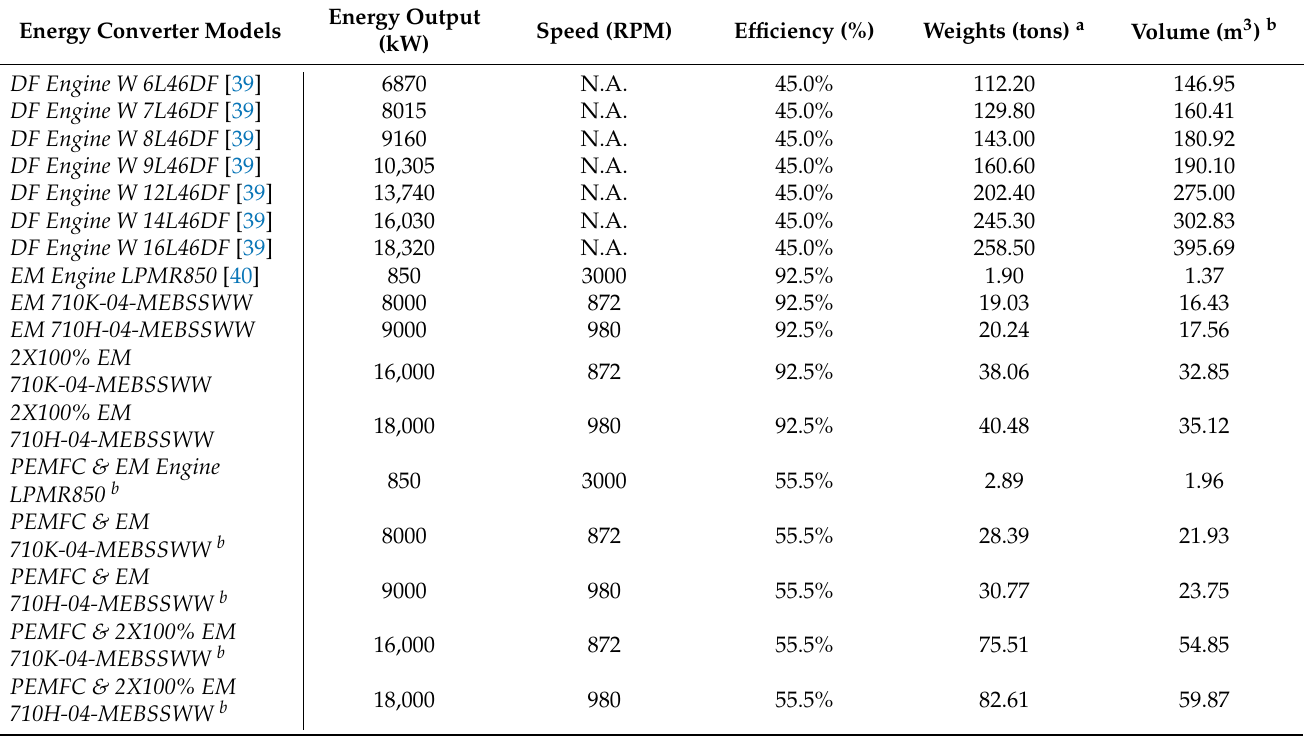
Table A1. Database of energy